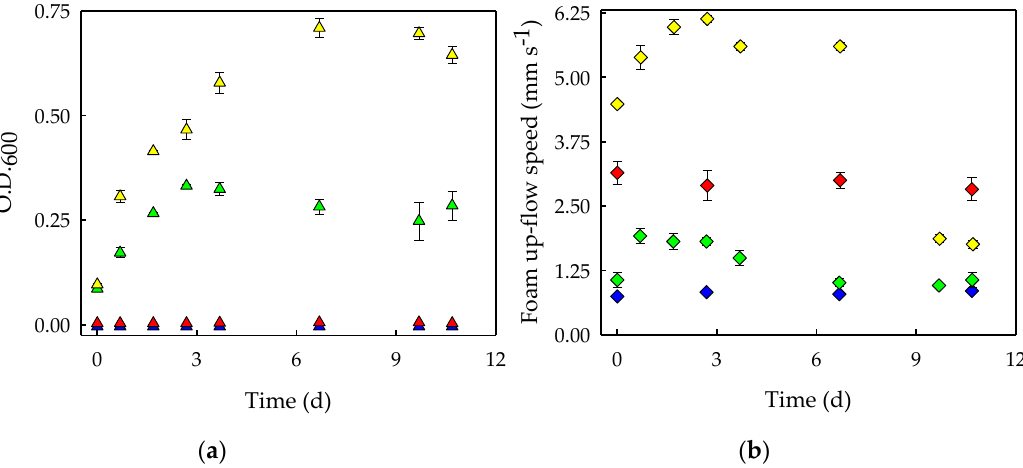
Figure 6. ( a ) Bacterial growth expressed as optical density at 600 nm (O.D. 600 ) during the biodegradability experiments with Saponin. ( b ) Foamability expressed as foam up-flow speed (mm s − 1 ). Culture conditions: Saponin-free culture media (blue symbols), Saponin-added culture media (red symbols), Saponin-free bacterial cultures (green symbols) and Saponin-added bacterial cultures (yellow symbols). Saponin was used at a concentration of 2 CMC. The average values of duplicate cultures are shown, together with their corresponding standard deviations.